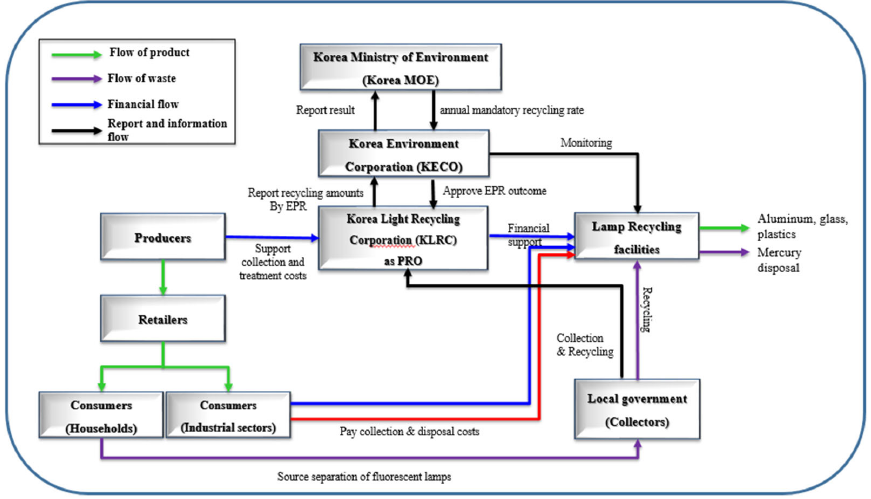
Figure 1. The recycling and management system of fluorescent lamps in South Korea.